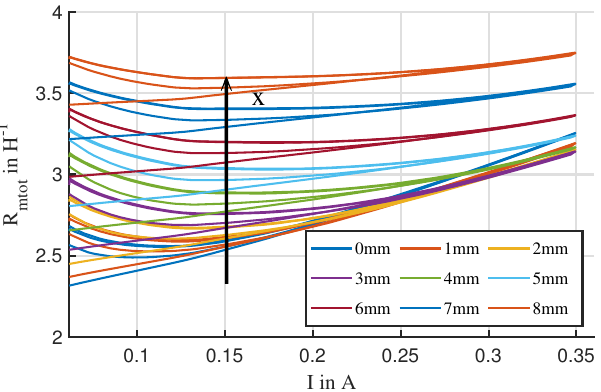
Figure 16. Total magnetic reluctance R mtot over the current for different positions.